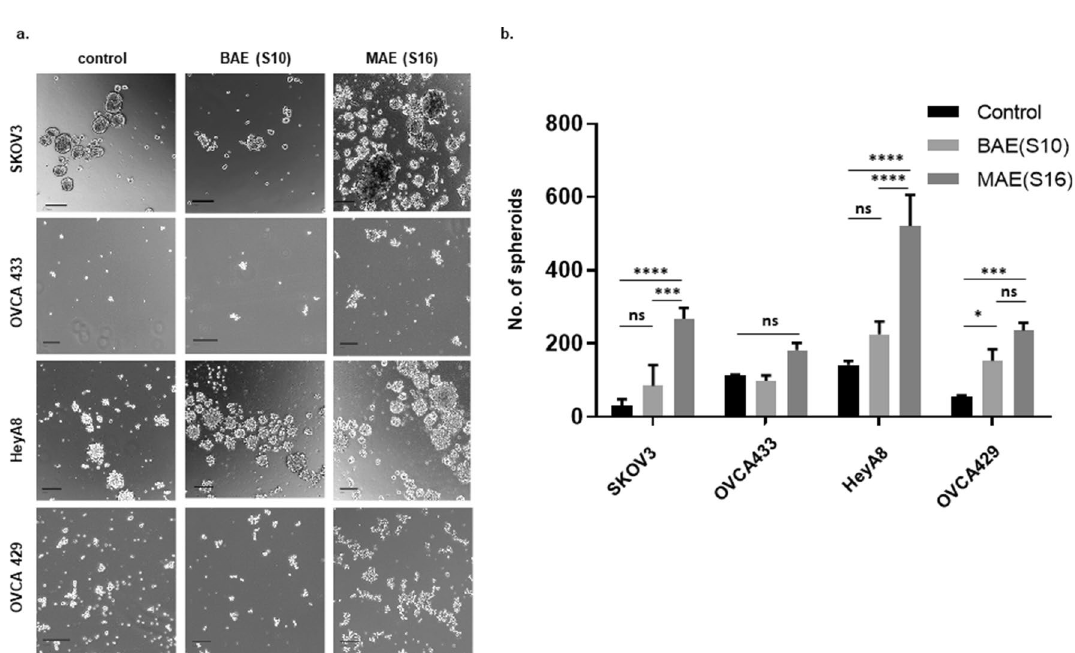
Figure 2. Exosomes isolated from benign and malignant tumor associated ascitic supernatants increase the growth of ovarian cancer spheroids. Ovarian cancer cells SKOV3, OVCA433 HeyA8, and OVCA429 were grown in low attachment plates as spheroids as control (without exosomes), as BAE (grown with 250ug/ml exosomes from benign ascitic supernatant) or as MAE (grown with 250ug/ml exosomes from malignant ascitic supernatant). Spheroids were photographed ( a ) after seven days and quantitated using an Oxford-Optronix Gelcount automated cell counting instrument (Sarasota Fl.) and represented as a bar graph ( b